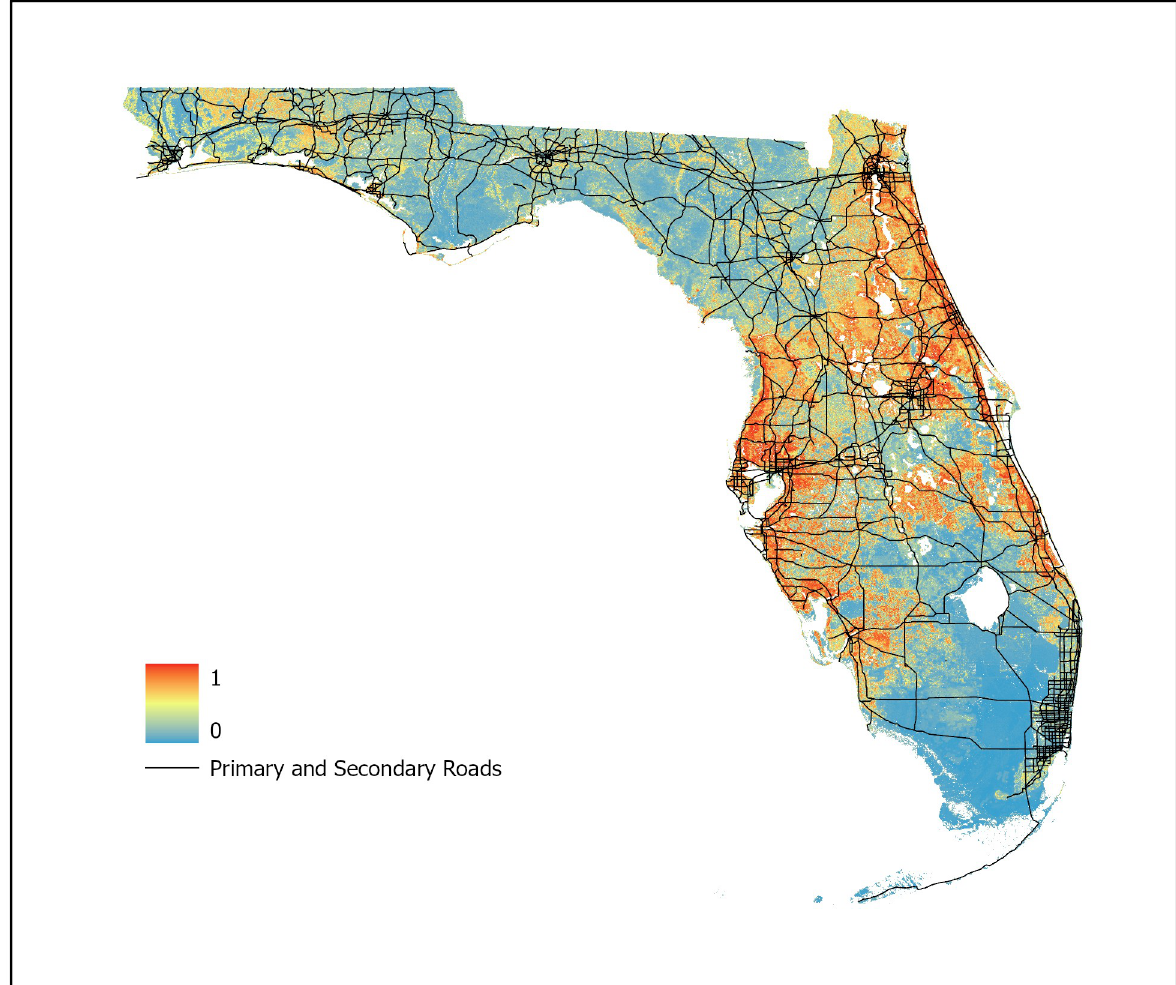
Fig 10. Ensemble West Nile virus model. Predictive values range from 0 to 1 with an AUC of 0.9939 (95% CI